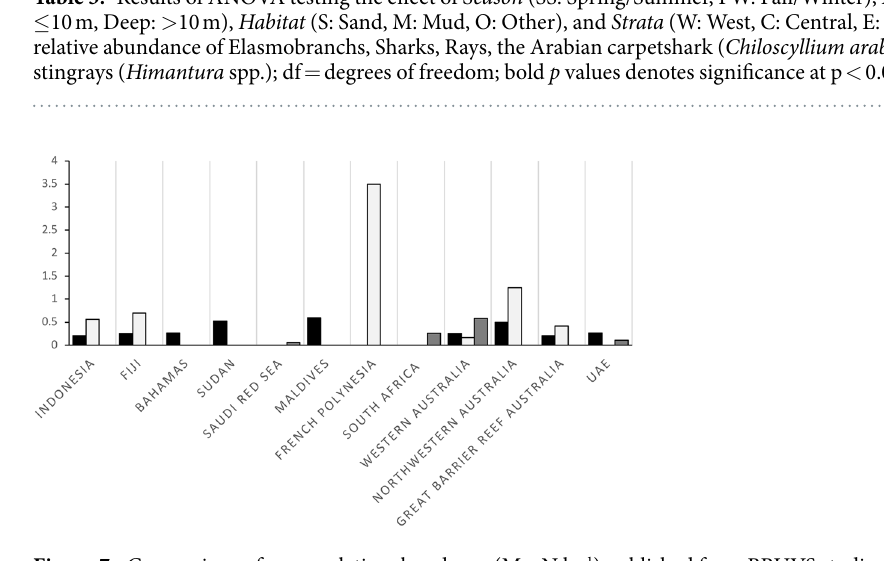
Figure 7. Comparison of mean relative abundance (MaxN h − 1 ) published from BRUVS studies from around the world for sharks in fished areas (black), sharks in no-take zones (light grey), and elasmobranchs in fished areas (dark grey). For the UAE, the dark grey column represents the CPUE of sharks and rays after removing the Arabian carpetshark ( Chiloscyllium arabicum ) and stingrays ( Himantura spp.) from the